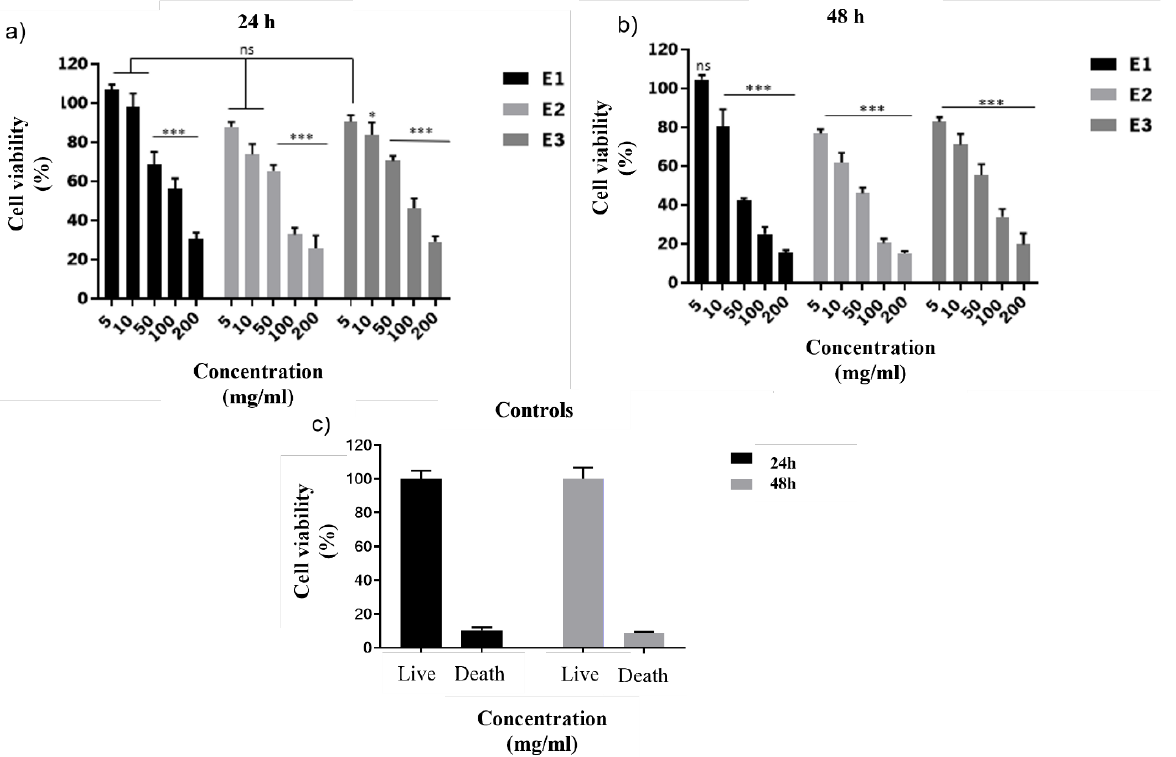
Figure 3. Cell viability measured by MTT assay at 24 h ( a ) and 48 h ( b ) of culture. Cell viability (%) is shown for each condition and each time point. Data represent the mean value of three independent experiments, each in triplicate. ( c ) Death control refers to the control of minimal cell survival; the results were compared with the living control. The statistically significant differences were indicated: * significantly different from the living control ( p ≤ 0.05); *** significantly different from lifetime control ( p ≤ 0.0001); ns = no statistically significant differences with lifetime control.